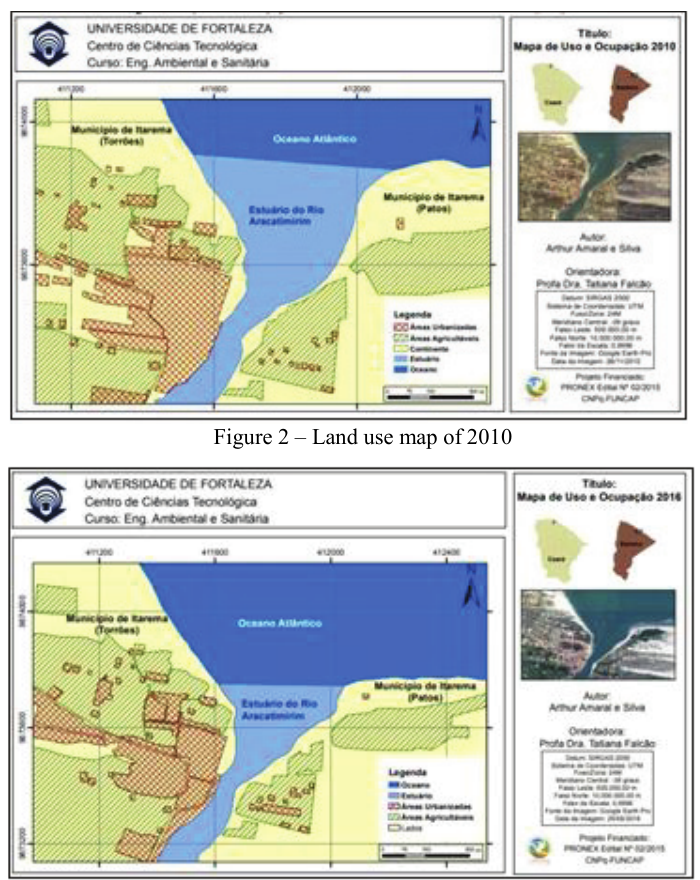
Figure 3 – Land use map of